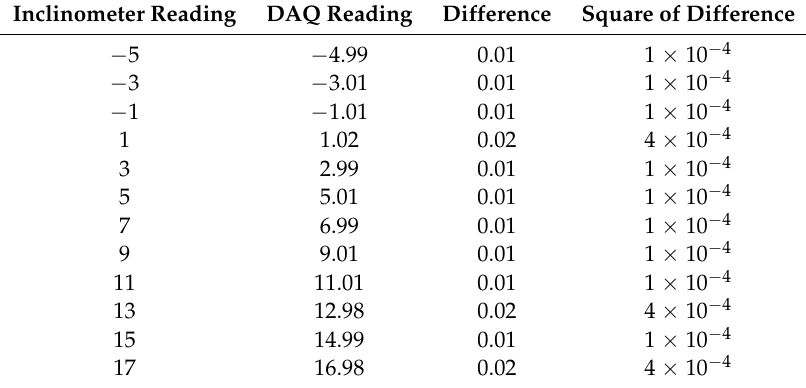
Table 5. Angle of attack calibration. Angle of attack was calibrated against inclinometer and data acquisition system of wind